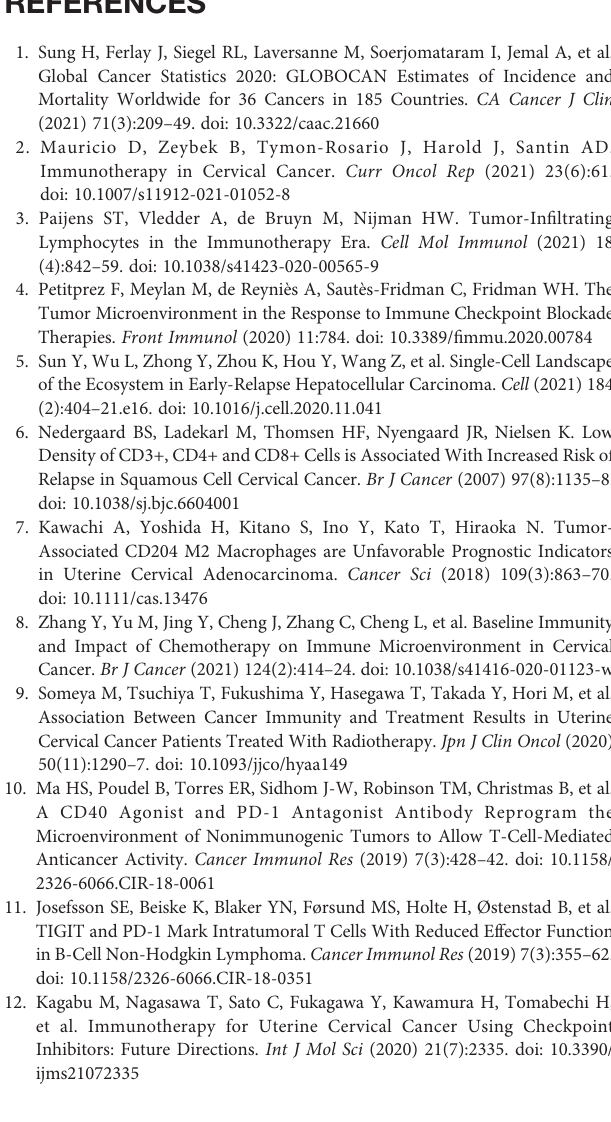
Supplementary Figure 6 | A univariate Cox hazard ratio analysis revealed that the Immunoscore was statistically different in almost all the subgroups classi fi ed by Supplementary Figure 7 | Spearman correlation analysis of the Immunoscore and tumor-in fi ltrating cells. Supplementary Figure 8 | Kaplan-Meier curves for overall survival (OS) of all CESC patients with multiple prognostic immune checkpoints. Log-rank test showed p < 0.05 respectively. their correlation with Immunoscore.